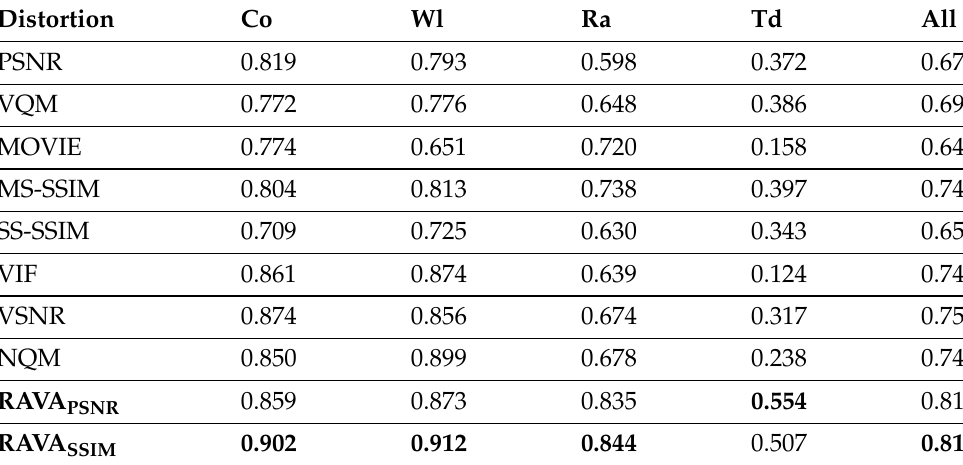
Table 2. Comparison of SCC (Spearman correlation coefficient)—mobile.